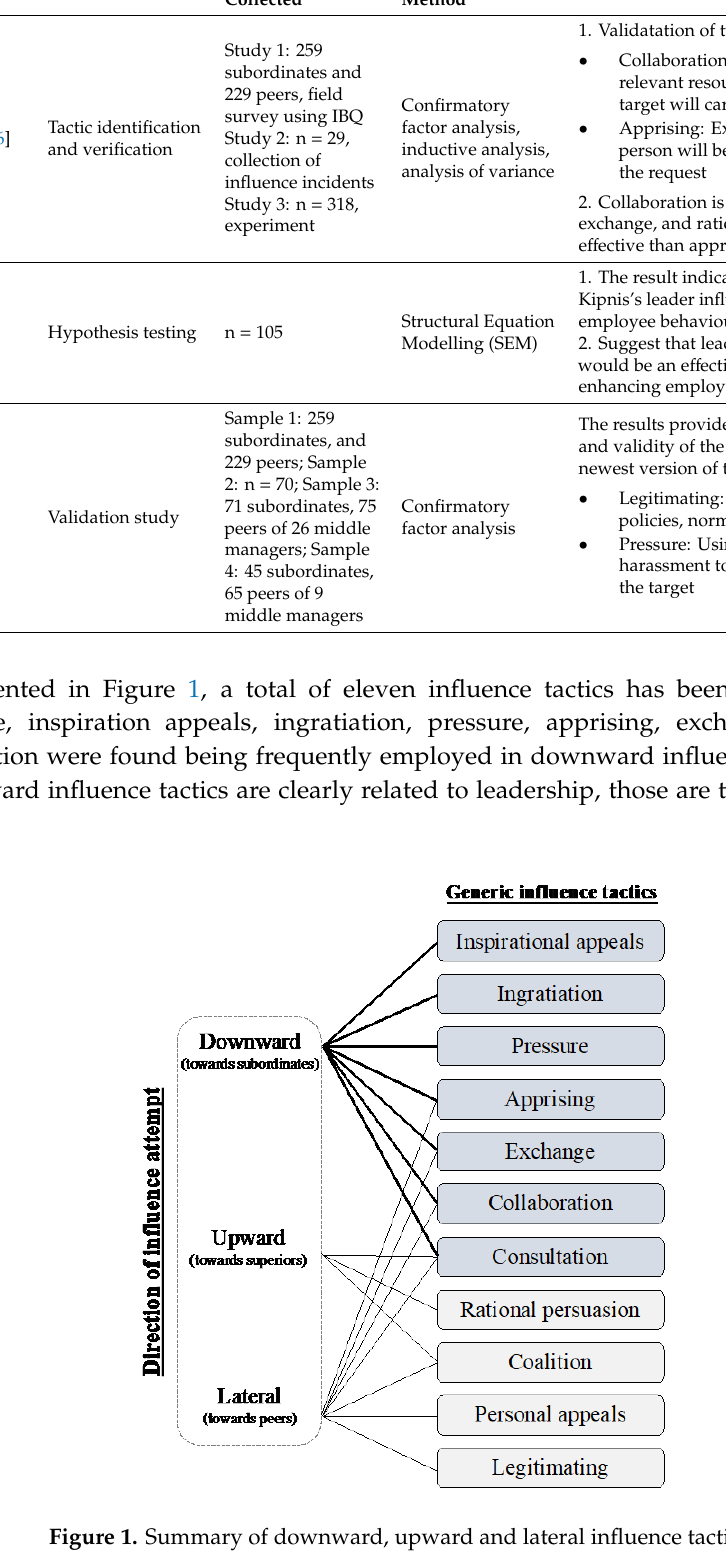
Figure 1. Summary of downward, upward and lateral influence tactics.